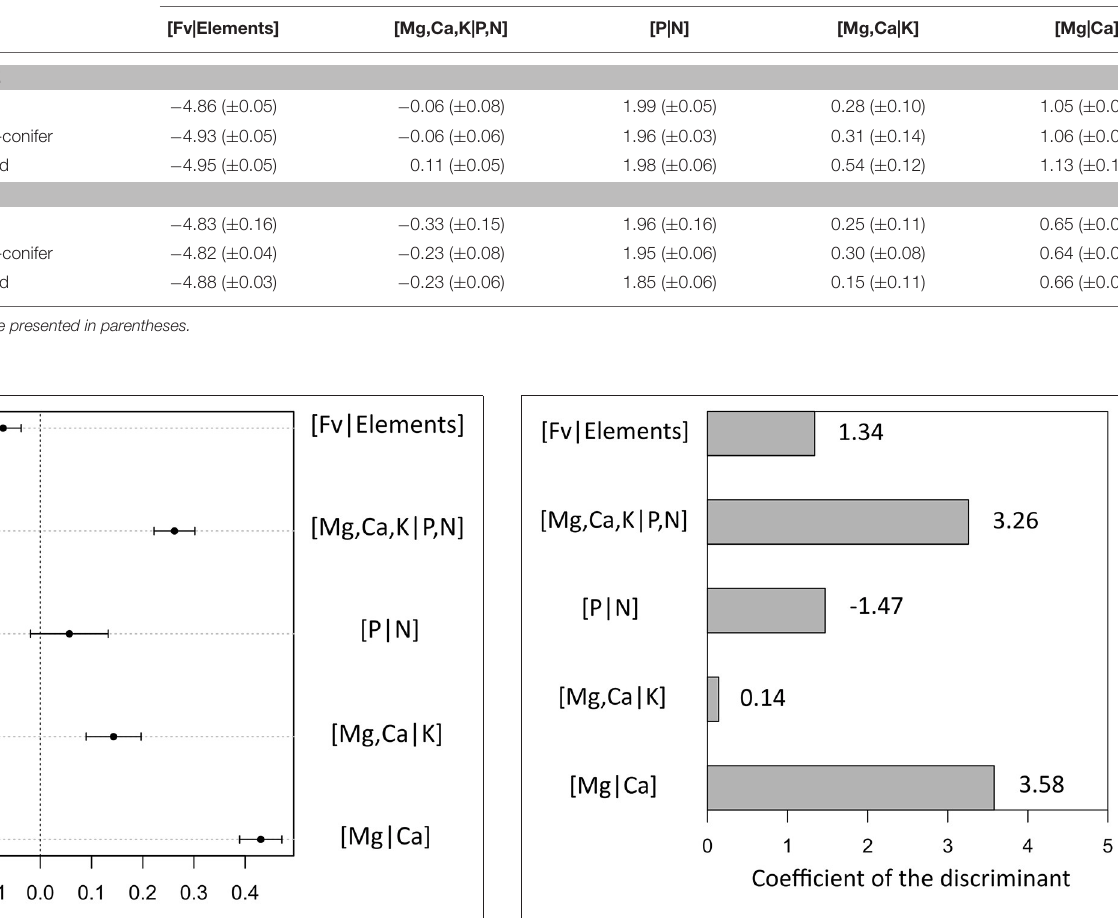
FIGURE 3 | Results of linear discriminant function analysis (DFA) between foliar balances of sugar maple (SM) and red maple (RM) seedlings. The 1st axis explains all of the variation. Subsequent classification analysis reports that 91.6 and 85% of responses were correctly classified for SM and RM seedlings, respectively. The higher the absolute value of the coefficient, the higher its ability to discriminate between groups. in Table 5 . The ranges of those foliar balances are